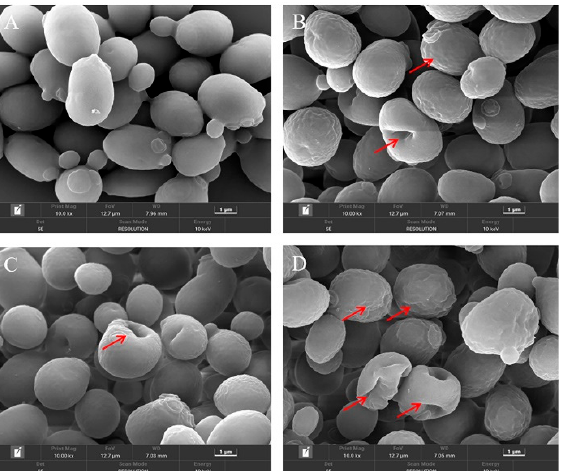
Figure 3. Field emission-scanning electron microscopy images of Saccharomyces cerevisiae cells after individual and combined treatments with cinnamon oil (CIN) (0.02%) and petit -high pressure CO 2 ( p -HPCO 2 ) (1.3 MPa) for 2 h at 25 °C. ( A ) control; ( B ) CIN; ( C ) p -HPCO 2 ; ( D ) CIN + p -HPCO 2 . The red arrows indicate the representative changes in cellular morphology.